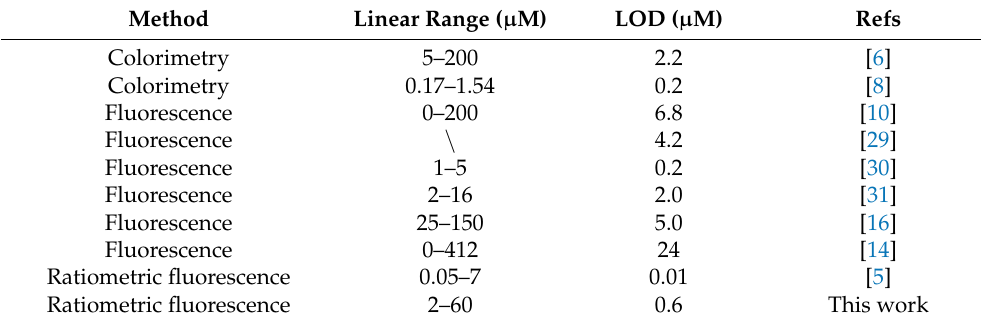
Table 1. Comparison of different methods for ClO − detection.